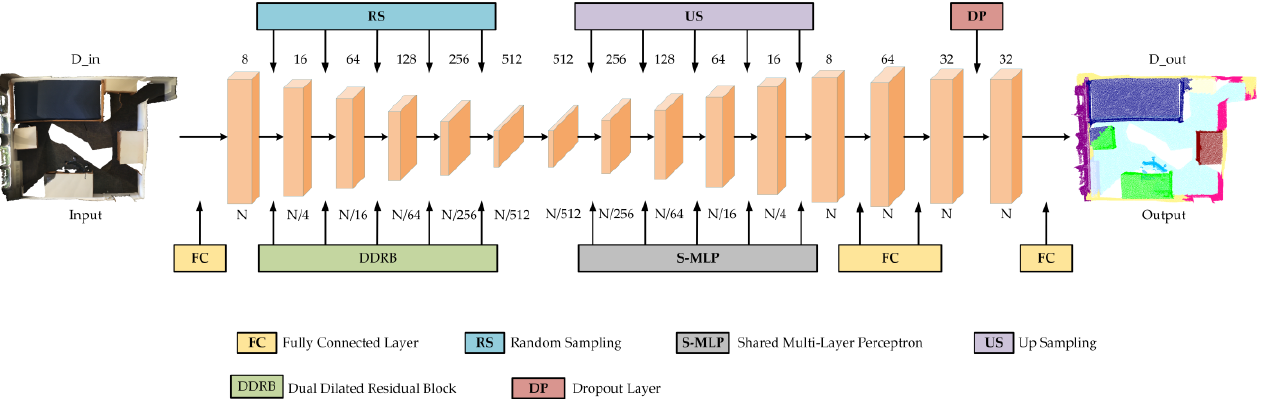
Figure 2. Network architecture. where D_in represents the input point-cloud dimension, D_out represents the output label dimension, the number above each layer structure in the figure is the dimension of each feature of this layer, and the number below is the number of features.